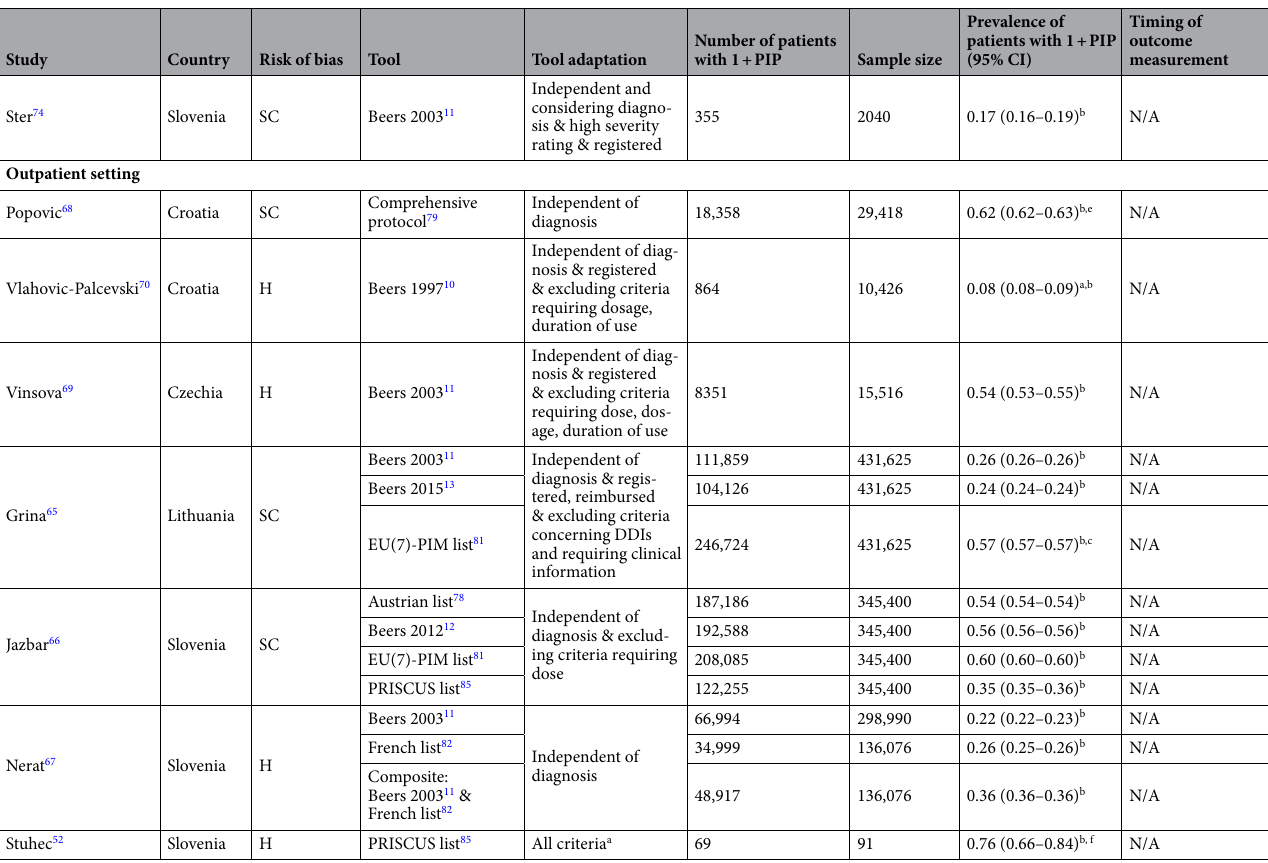
Table 2. Results of individual studies. DDI Drug-drug interaction, GheOP3S Ghent Older People’s Prescriptions community Pharmacy Screening, H High, L Low, LTC Long-term care, N/A Not applicable, SC Some concerns, START Screening Tool to Alert doctors to Right Treatment, STOPP Screening Tool of Older Person’s Prescriptions. *Indicates the major publication for the study (the study was described in three reports). °One report described two studies. a Data were obtained and/or confirmed from study authors. b Calculated. c Discrepancies in publication resolved in correspondence. d Data for persons aged 65 + years were obtained by correspondence. e A part of the criteria considering diagnosis was presented separately as a percentage of a total number of prescriptions (1,315,624) that was 2.0%. f Data were obtained from the master’s thesis by Gorenc 86